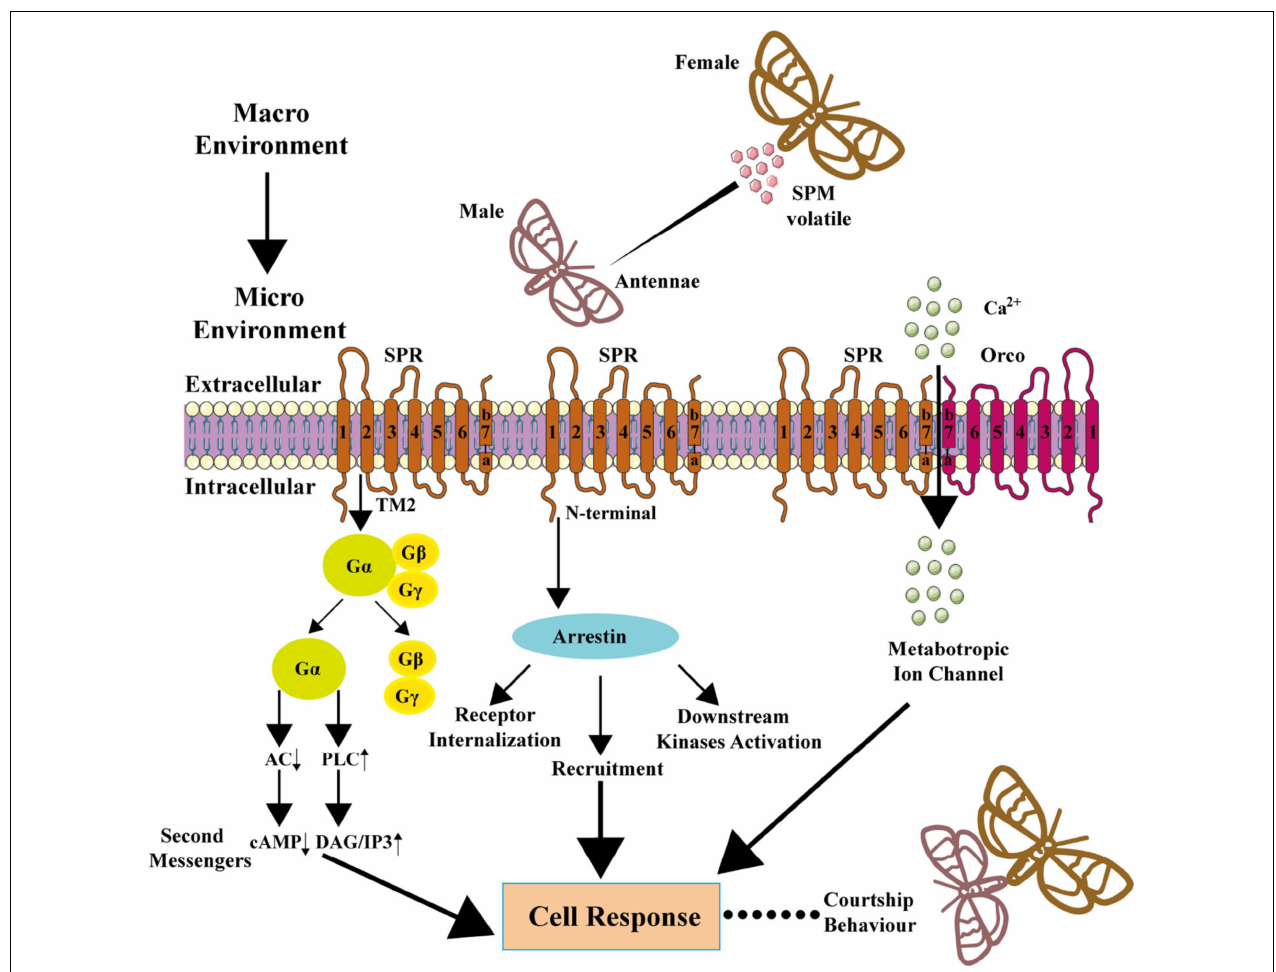
FIGURE 4 | Downstream signaling pathway of SPR and metabotropic channel of SPR-Orco. In macro environment, male insects sense the SPM released by female insects through an olfactory sensory neuron in antennae, and SPM works as an agonist to SPR, and signal transduction leads to ultimate mating